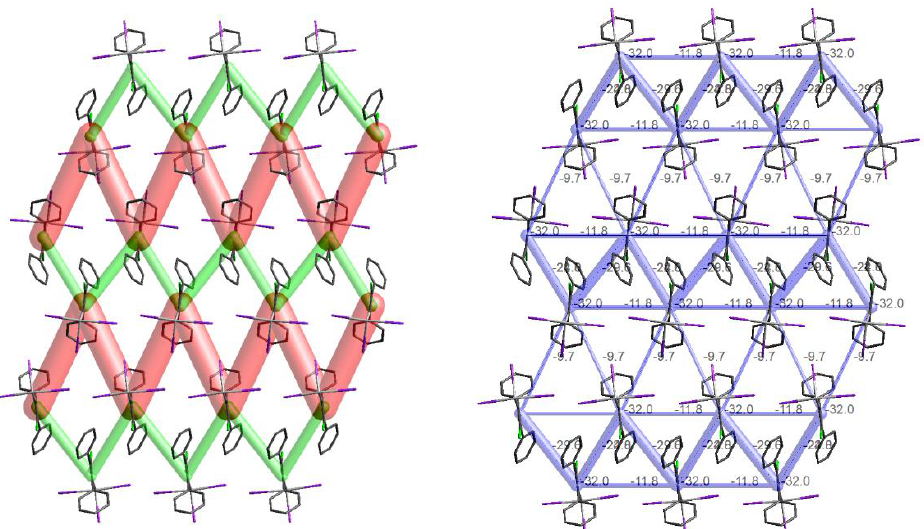
Figure 9. Energy frameworks of 2 α , showing the contribution of dispersion and electrostatic interactions into the total intermolecular interaction energy ( a ) and total intermolecular interaction energy ( b ). Color code: red (electrostatic, cut-off 20 kJ/mol), green (dispersion, cut-off 28 kJ/mol). Blue cylinders show total energy framework (Crystal Explorer 21.5, cut-off 9 kJ/mol). Intermolecular interaction energy values are indicated in kJ/mol.